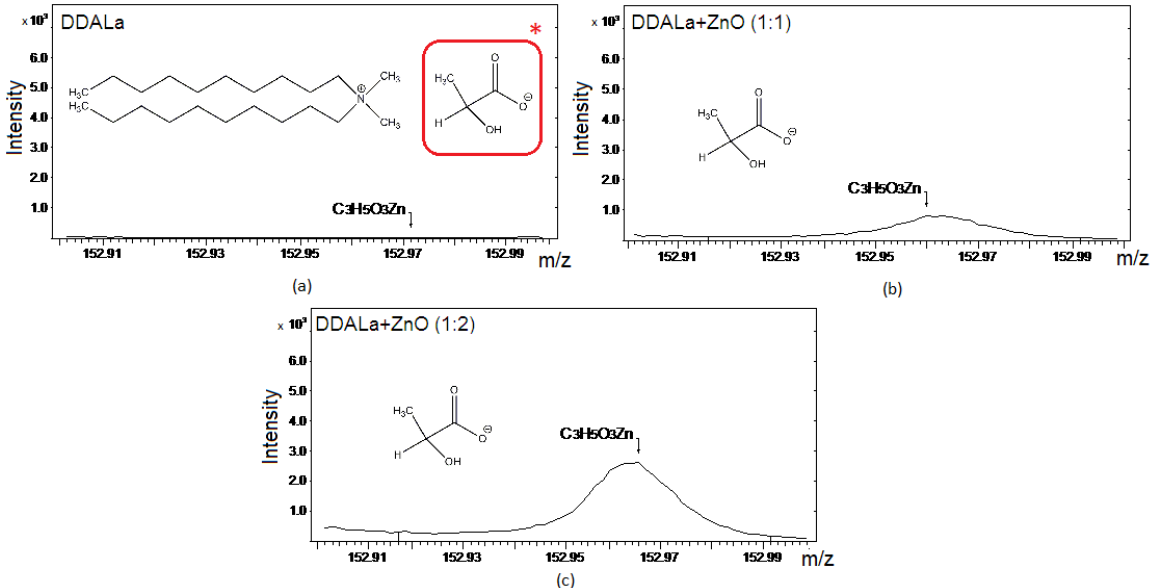
Figure 9. TOF-SIMS spectra for C 3 H 5 O 3 Zn + ion recorded for: ( a ) pure DDALa; ( b ) DDALa and ZnO mixture with the weight ratio of 1:1; ( c ) DDALa and ZnO mixture with the weight ratio of 1:2; (*lactate anion of DDALa).